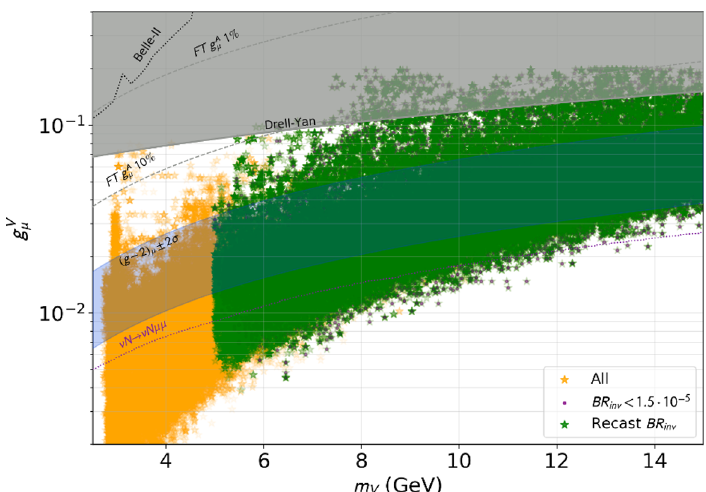
Figure 4 . In yellow model points in which the b ! s anomalies, BR ( B s ! (cid:22)(cid:22) ), and ( g (cid:0) 2) (cid:22) are (cid:12)tted at the 2 (cid:27) level. Superimposed points are allowed after the limits from B ! K + inv. are applied, as reported by CLEO [87] (purple) or using our recast procedure (green), cf. appendix A. Grey shaded region is excluded by precision measurements of Drell-Yan at the LHC [79].